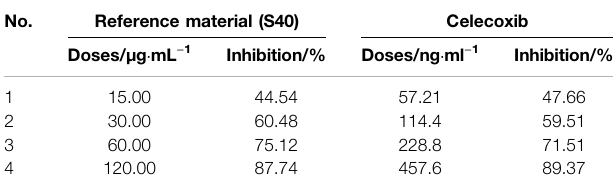
TABLE 2 | Biopotency conversion between LHQW reference and